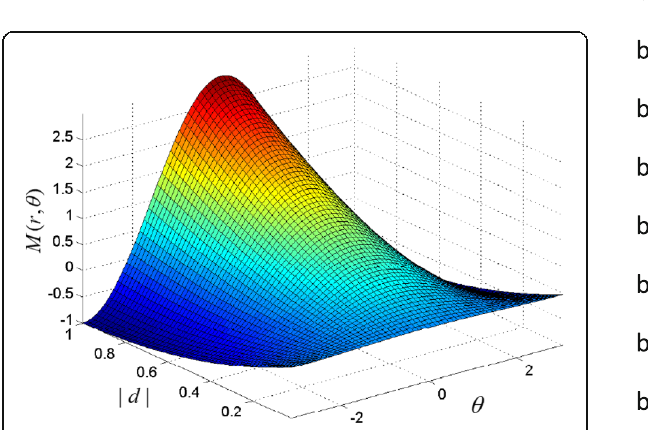
Fig. 1 Variation of M ( r ( m ), θ ( m )) versus | d | and θ ( m )